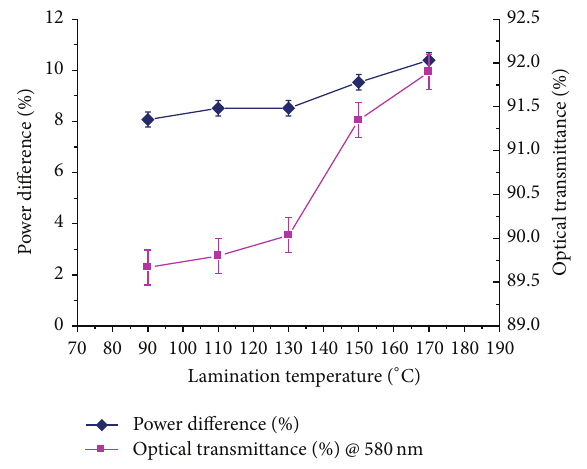
Figure 10: The power difference ratio and the optical transmittance as functions of the lamination